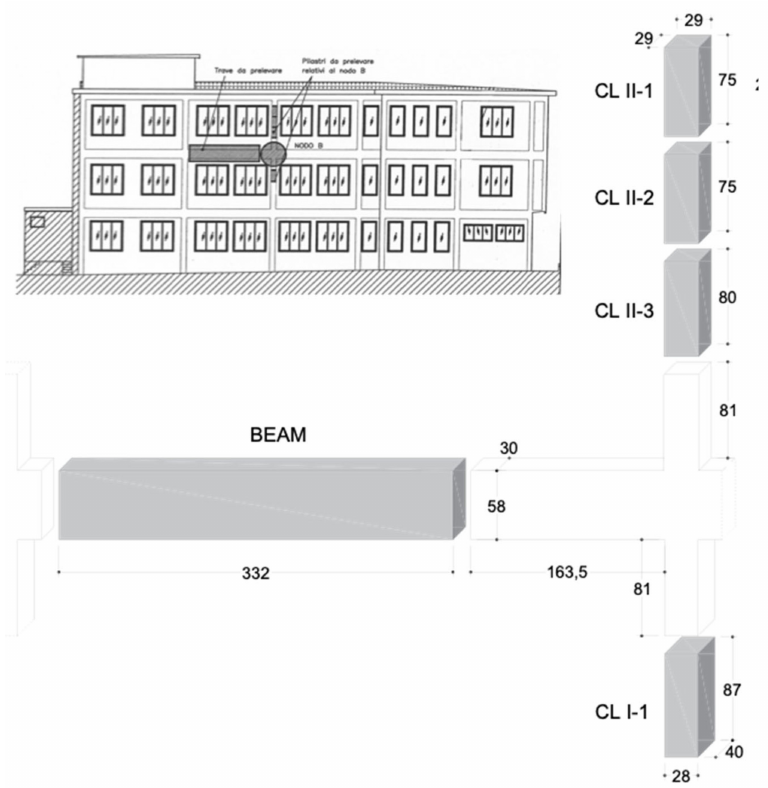
Figure 1. The five reinforced concrete elements extracted from the Italian school